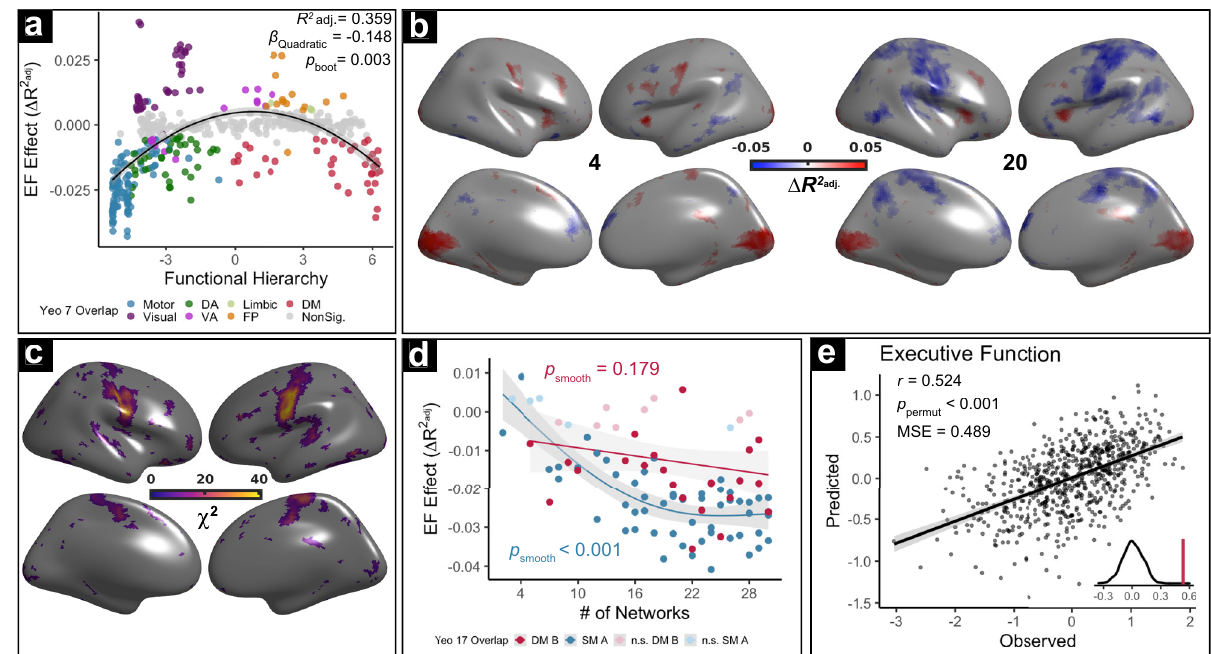
Fig. 6 Multi-scale network coupling is associated with executive function. a Network-level relationships between coupling and EF are quadratically related to transmodality. Speci fi cally, segregation of both sensorimotor and default-mode networks is associated with better EF. These associations with EF are dissociable from normative developmental effects (Fig. 3c) where default-mode segregation and sensorimotor integration are observed. The statistical test was two-sided. b Analyses at scales 4 and 20 reveal differing associations with EF. While between-network coupling of visual, insular, and dorsolateral prefrontal cortical areas is consistently associated with greater EF ( Q FDR < 0.05), opposite associations with EF were present in motor cortex at coarse and fi ne scales. c Tests of age-by-scale interactions using GEEs reveal that scale effects are strongest in the sensorimotor cortex. d Scale is differentially linked to EF associations with coupling in higher-order and lower-order networks. As for age, effects in somatomotor networks tend to be more scale-dependent than those in association networks. The effect of age across scales is plotted for networks predominantly overlapping with the lowest-order (blue; Somatomotor-A) and highest-order (red; Default Mode-B) of the Yeo 17 networks. e Complex patterns of multi-scale coupling between personalized networks accurately predicts EF in unseen data. Cross-validated ridge regression with nested parameter tuning was used to predict EF of unseen data using each participant ’ s multivariate pattern of coupling across scales. Error bands depict the 95% con fi dence interval, statistical tests are two-sided for d and one-sided for e . MSE = mean squared